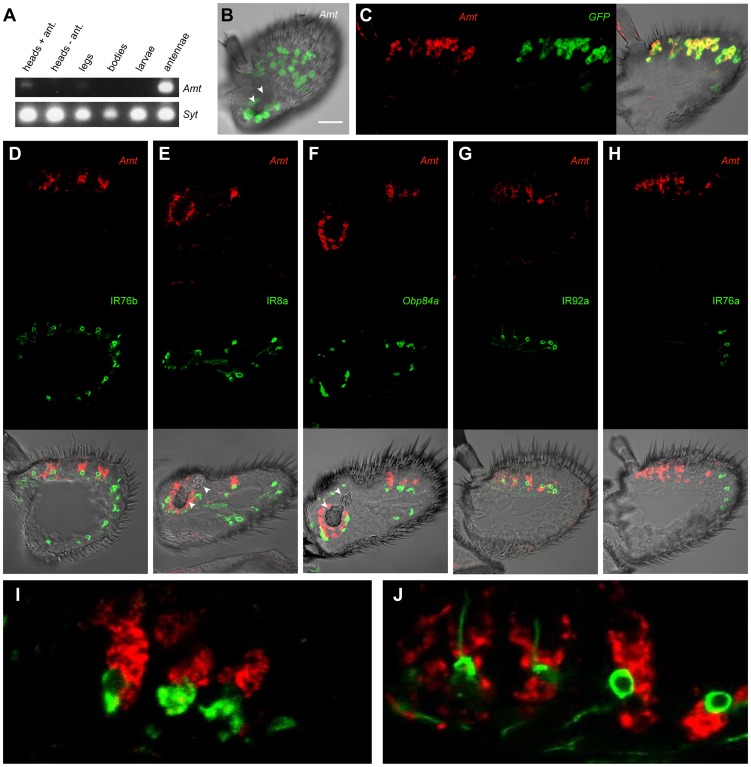
Expression of Amt.
(A) RT-PCR analysis of Amt expression in CS. Synaptogmin was used as a positive control. (B) Whole-mount confocal image of a third antennal segment of an Amt-GAL4; UAS-mCD8::GFP fly. GFP expression is seen in large, amorphous auxiliary cells, but not in neurons. White arrowheads indicate the sacculus here and in panels E and F. Scale bar  = 30 µm. (C) Confocal image of an in situ hybridization to an antennal section from an Amt-GAL4; UAS-mCD8::GFP fly using antisense probes for Amt (red) and GFP (green). The two probes co-localize. (D, E, G, H), confocal images of antennal sections labeled with an antisense probe for Amt (red) and an antibody against GFP (green) driven by (D) IR76b-Gal4, (E) IR8a-Gal4, (G) IR92a-Gal4, and (H) IR76a-Gal4. IR76b-Gal4 and IR8a-Gal4 are co-receptors that label at least one ORN in each surface coeloconic sensillum type (ac1–4). IR8a-Gal4 also labels coeloconic ORNs in the third chamber of the sacculus. Amt is detected in larger neighboring auxiliary cells in a subset of the coeloconic sensilla. (F) Confocal image of an in situ hybridization to an antennal section from a CS fly using antisense probes for Amt (red) and Obp84a (green). Amt is expressed in different auxiliary cells from those that express Obp84a, which is also expressed in coeloconic sensilla. (G) Expression of Amt on the antennal surface is found surrounding the IR92a ammonia receptor-expressing neurons, which are in ac1. (H) Amt is not detected in ac4 sensilla, which contain ORNs that express IR76a. (I, J) Higher magnification images of (F) and (G) respectively.